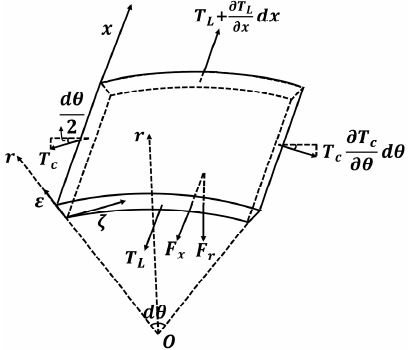
Figure 2. Micro element force model of blood vessel wall. In this model, x represents the axial direction, r represents the radial direction, T C and T L represent the peripheral and axial tension of the vascular wall, F r and F x represent the radial and axial components of the blood viscous friction force on the vascular wall, and ξ and ζ represent the radial and circumferential displacement of the vascular wall under the action of external force, respectively. Assuming that blood is a Newtonian fluid, according to the constitutive equation of Newtonian fluid [24], the viscous stress that acts on the inner surface of the blood vessel wall is shown in Formula (6).